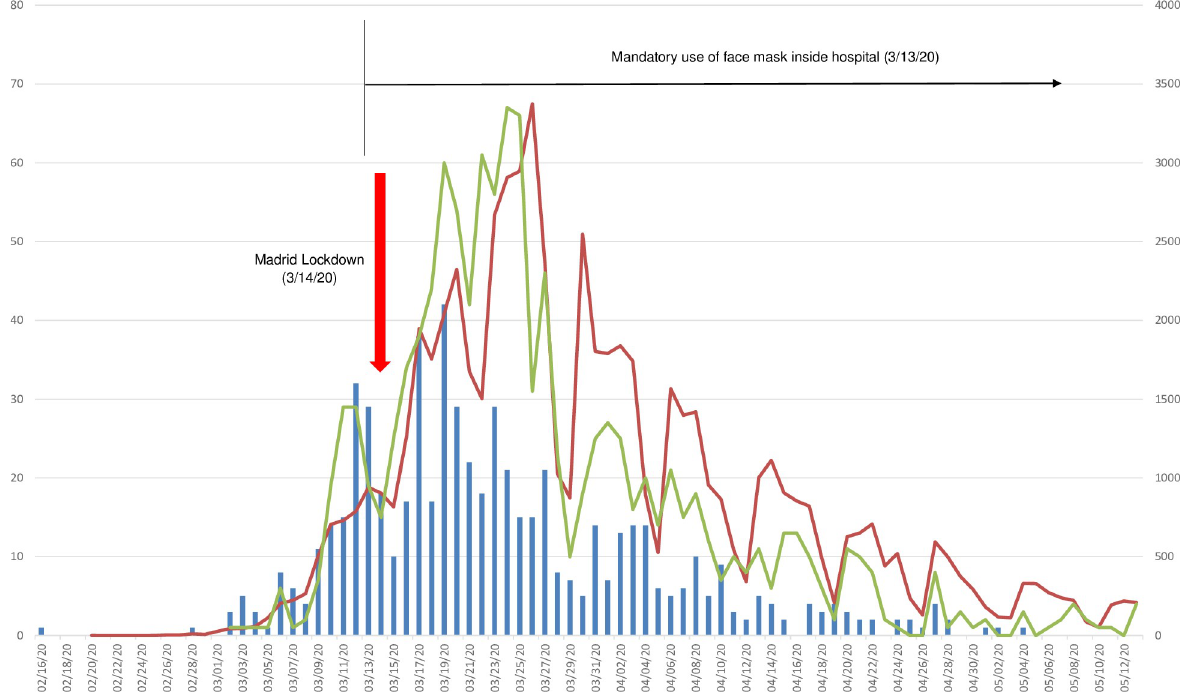
Fig 1. Epidemiologic curve from symptoms onset dates in relation to cases diagnosed in Madrid. Blue columns are the number of HCW from HUF that declared COVID-19 compatible symptoms by date of symptom onset; red line is rRT-PCR-based diagnosed cases by date of diagnosis in Community of Madrid � ; green line is rRT-PCR-based diagnosed cases by date in HUF �� . HCW: healthcare workers; HUF: Hospital Universitario de Fuenlabrada. � Source: based on RENAVE data [12]. �� Source: based on own Laboratory Medicine data.